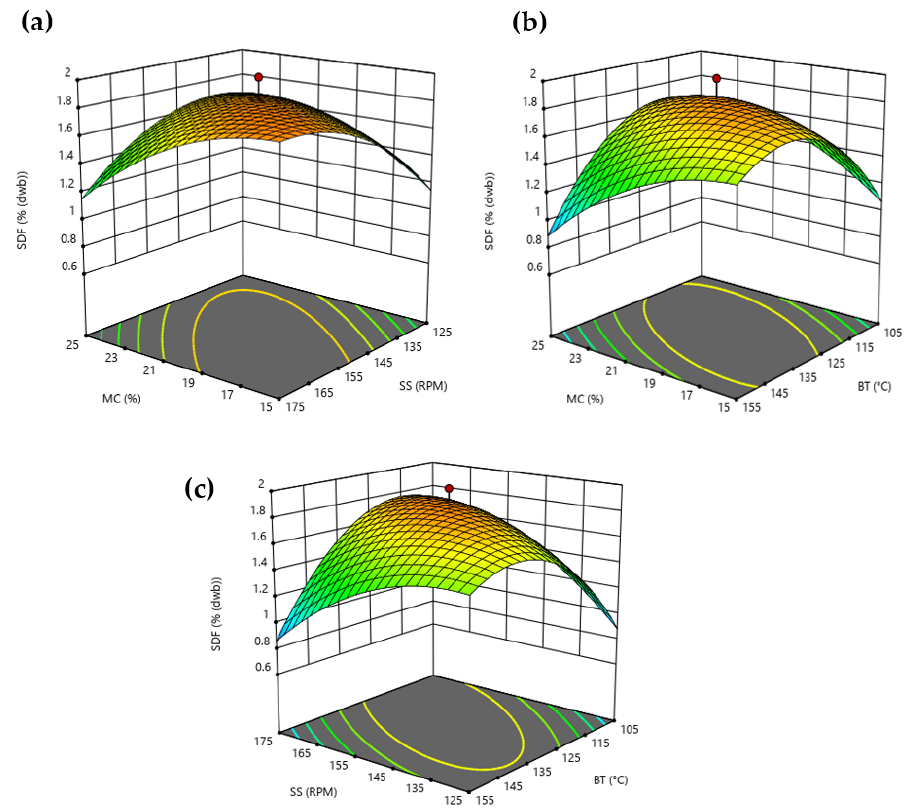
Figure 1. Response surface plots showing the effects of ( a ) moisture content (MC) and screw speed (SS), ( b ) moisture content (MC) and barrel temperature (BT), and ( c ) barrel temperature (BT) and screw speed (SS) on soluble dietary fiber content (SDF).